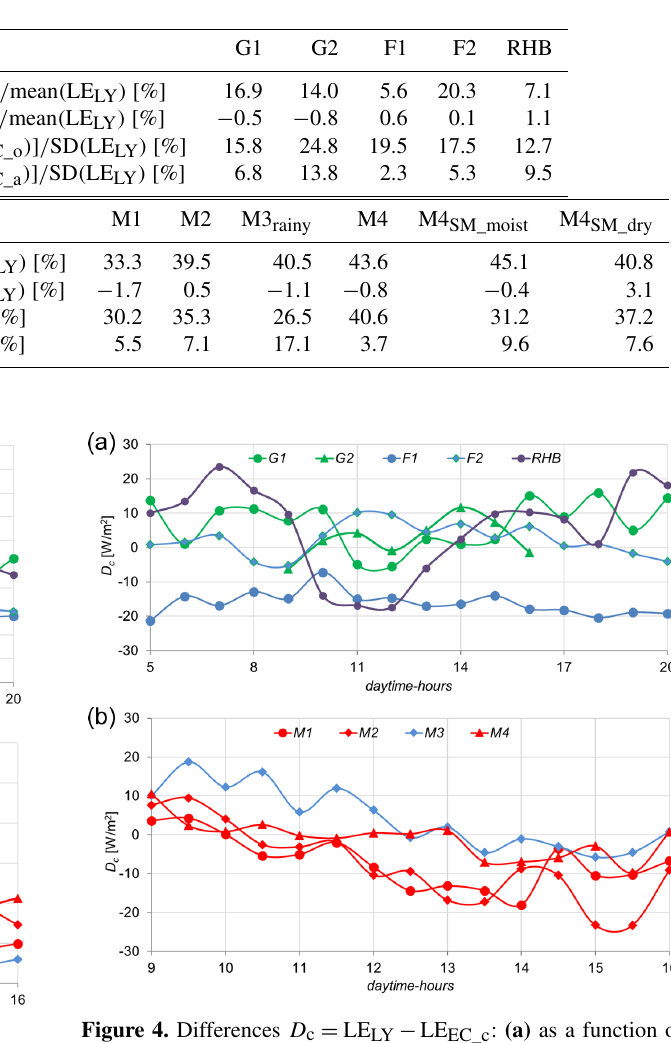
Table 5. (a) Comparison of the LY − EC differences (means: upper two lines; SDs: lower two lines) before and after adjustment of the EC values, humid. (b) Comparison of the LY − EC differences (means: upper two lines; SDs: lower two lines) before and after adjustment of the EC values, Majadas.